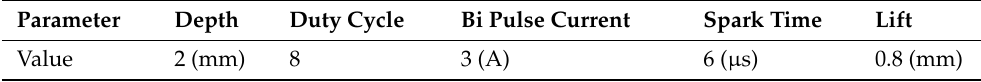
Table 3. Values of fixed input